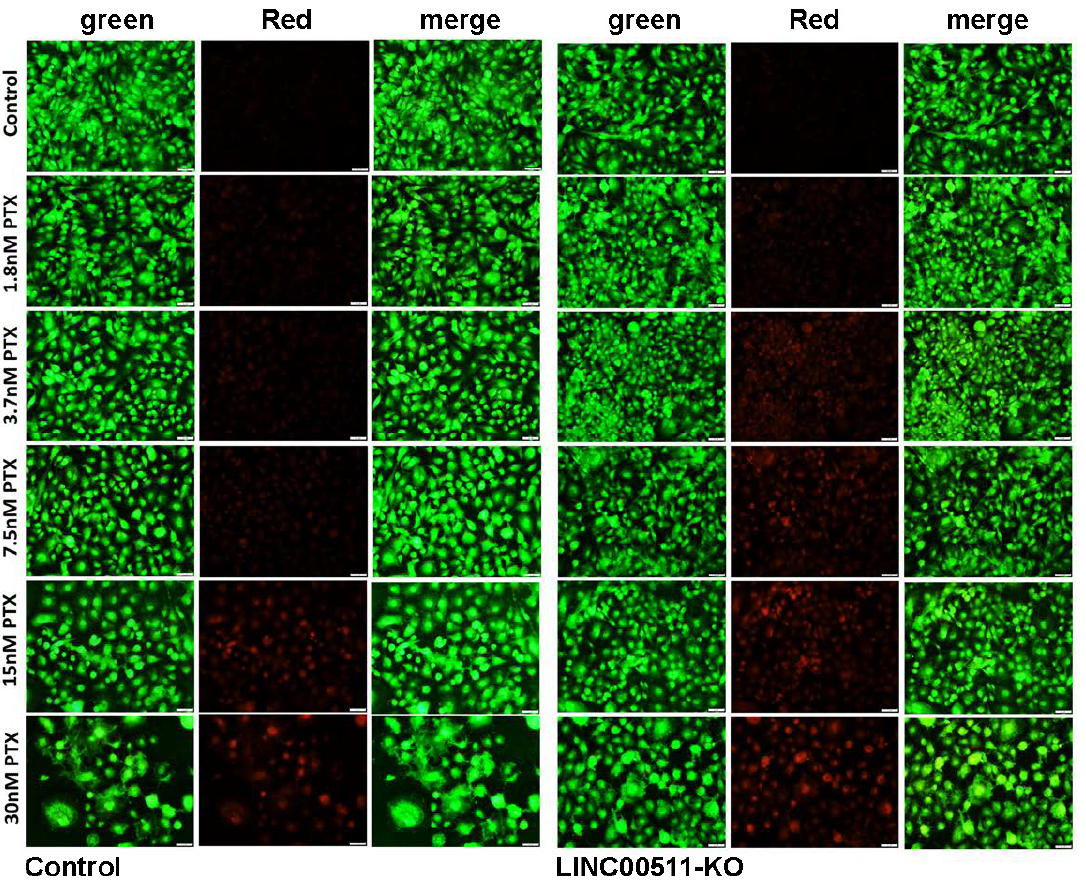
Figure 8. Viability staining for LINC00511-KO cells in the absence or presence of Paclitaxel. Repre- sentative fluorescence images of HCC70 parental and LINC00511-KO cells (±different concentration (1.8–30 nM) Paclitaxel). The cells were stained with acridine orange/ethidium bromide to detect live and dead cells.